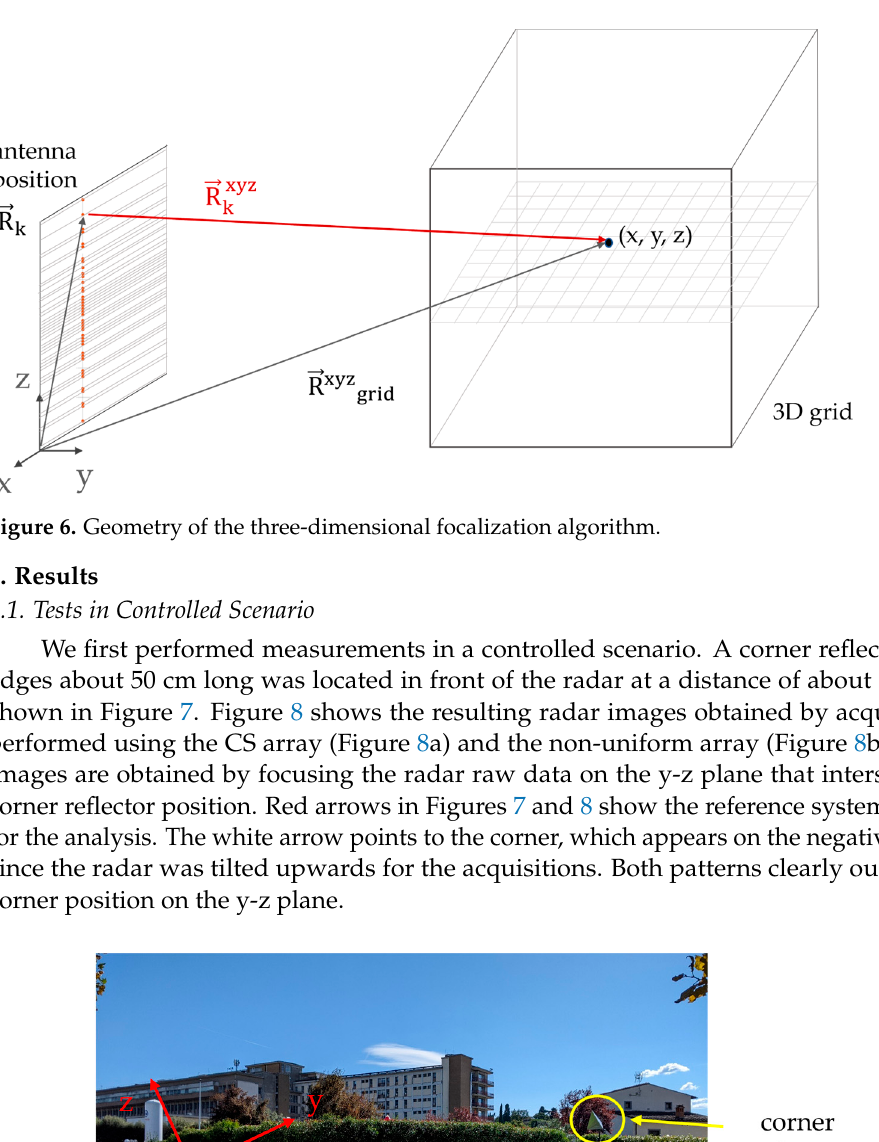
the radar is tilted up, the white arrow evidence the direction between radar and corner reflector.